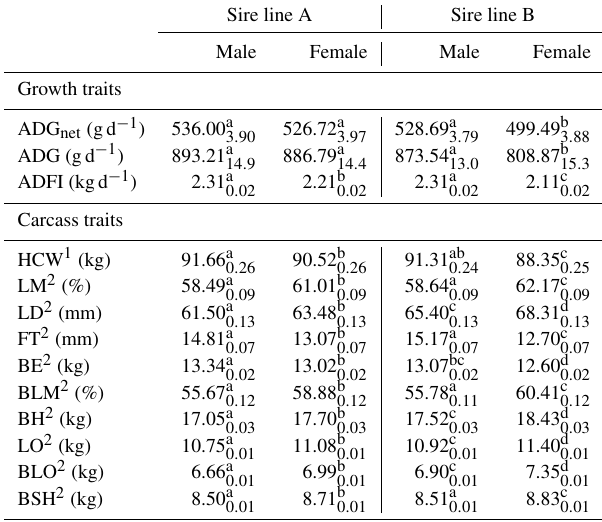
Table 6. LSQ mean (with SE as index) of growth and carcass traits according to the birth weight classes (BW Q